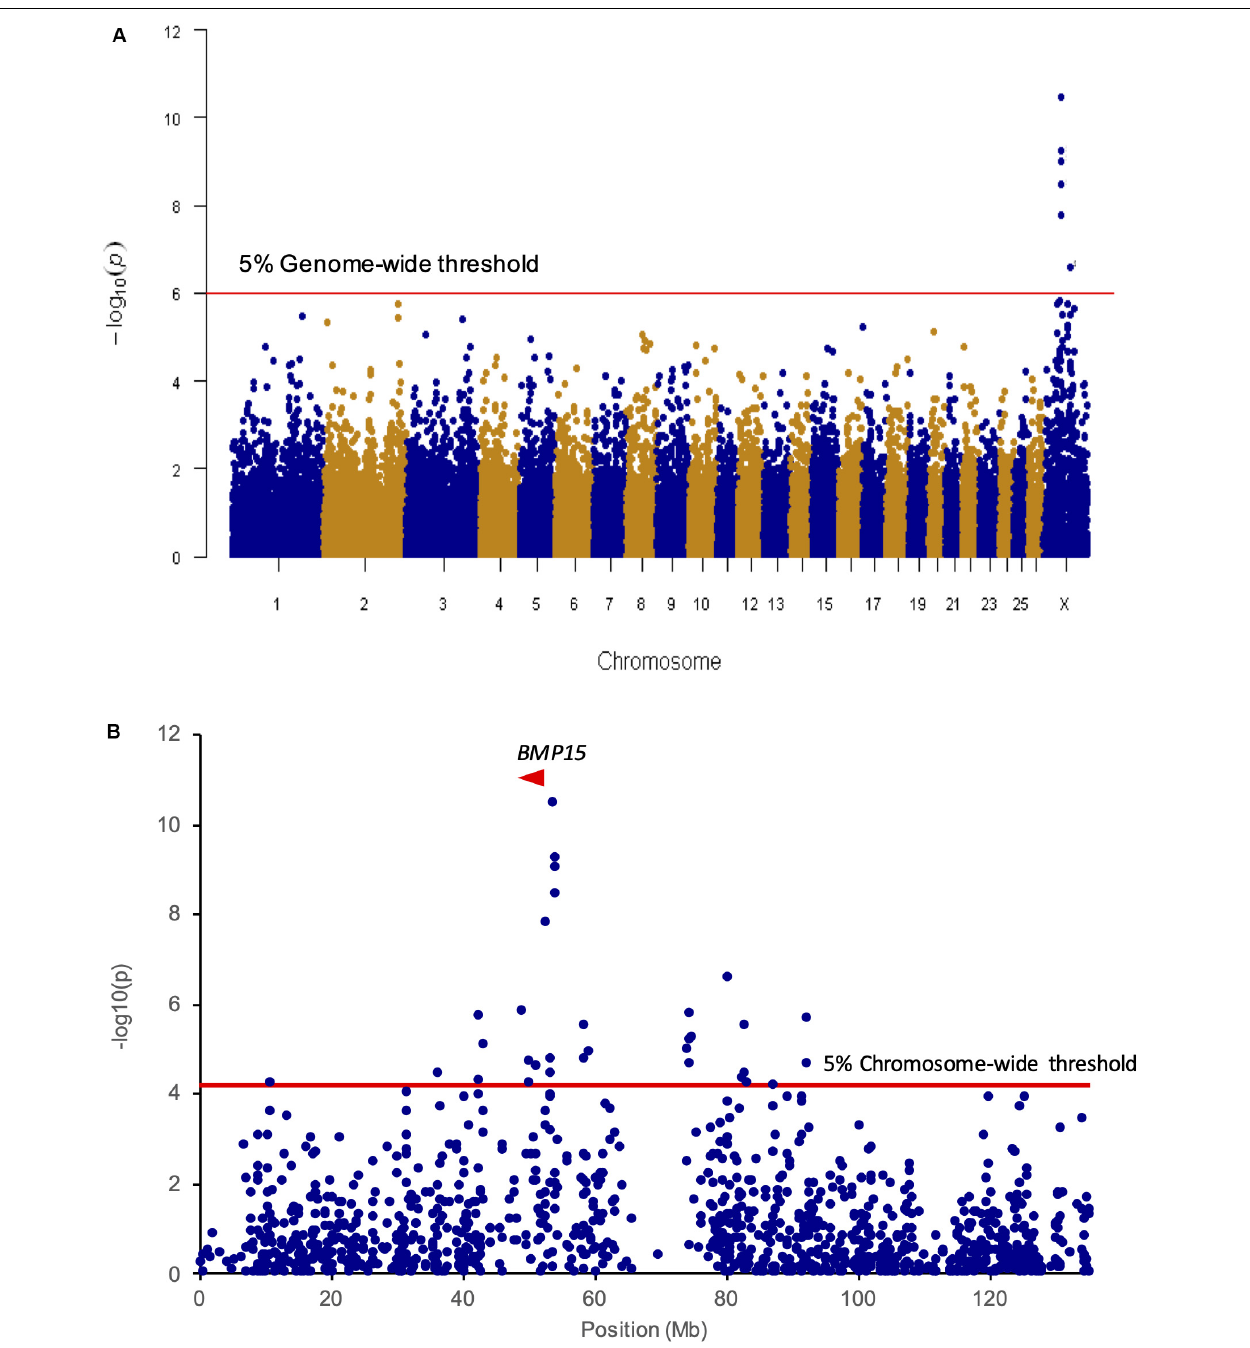
FIGURE 1 | Genome- and chromosome-wide association results. (A) Genome-wide association results for litter size in the NV sheep population. Manhattan plot shows the combined association signals [-log 10 ( p- value)] on the y -axis vs. SNPs position in the sheep genome on the x -axis and ordered by chromosome number (assembly OARv3.1). Red line represents the 5% genome-wide threshold. (B) OARX chromosome-wide association results. The curve shows the combined association signals [-log 10 ( p- value)] on the y -axis vs. SNPs position on the X chromosome on the x -axis (assembly OARv3.1). Red line represents the 5% chromosome-wide threshold. The BMP15 gene location is indicated by a red arrowhead.